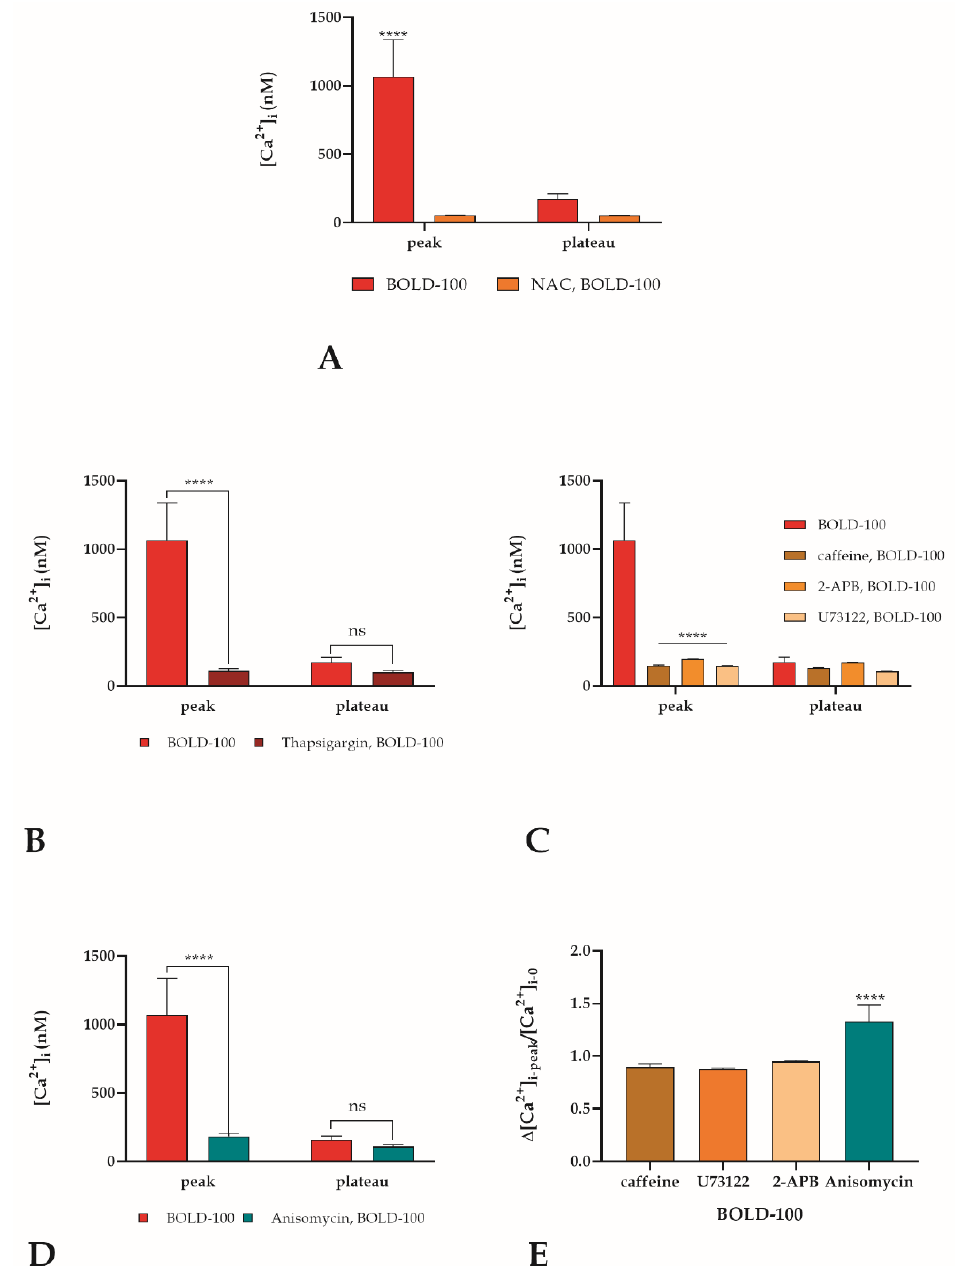
Figure 6 . Origin of cytosolic Ca 2+ after treatment with BOLD-100. [Ca 2+ ] i variation after BOLD- treatment recorded at 5 sec intervals in REN cells in the presence or absence of: ( A ) 50 mM NAC; ( B ) 5 µ M thapsigargin; ( C ) 50 µ M 2-APB or 10 mM caffeine or 10 µ M U73122; ( D ) 200 µ M anisomycin. Data are means ± SEM of Ca 2+ peak response recorded in different cells. Number of cells: 40 cells from three experiments for each condition. Statistics indicate differences at peak or plateau level for each condition (**** p < 0.0001; ns not significant, two-way ANOVA followed by Bonferroni correction). ( E ) Comparison between inhibitors in ( C , D ) expressed as ∆ [Ca 2+ ] i-peak /[Ca 2+ ] i-0 ; Data are means ± SEM of Ca 2+ Δ[Ca 2+ ] i-peak /[Ca 2+ ] i-0 recorded in different cells. Number of cells: 30 cells from three experiments for each condition. Statistics indicate differences between different conditions (**** p < 0.0001, one-way ANOVA followed by Dunnett ’s post-test).